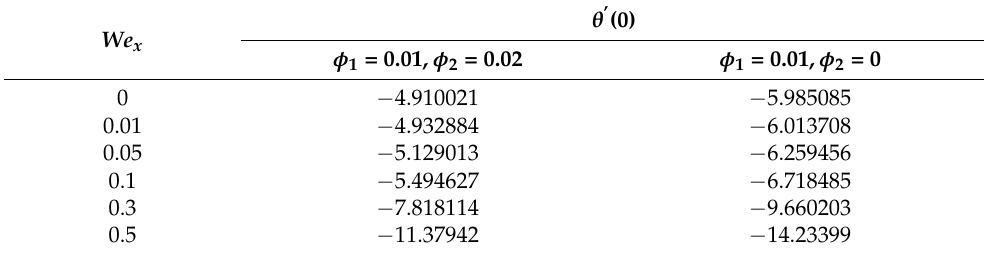
We undergoes variation, numerical approximations x ( ) 0 θ′ based on specific parameters, including